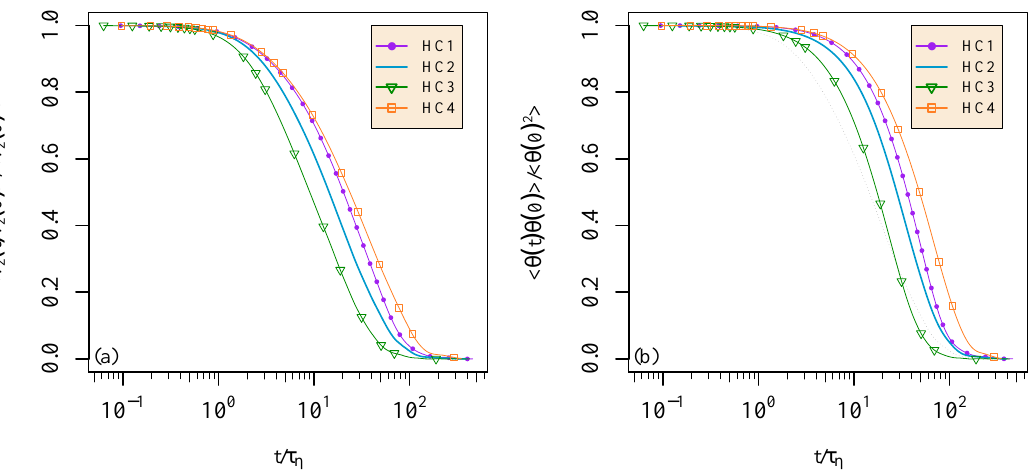
Figure 4. Lagrangian autocorrelation function of ( a ) the velocity aligned with gravity v z , and ( b ) the thermal fluctuations θ . In ( b ) a dotted grey line is provided in the background as a reference for the autocorrelation function of v z in the Pr = 1 simulation HC2. Time is given in units of the Kolmogorov time-scale τ η . Triangular brackets indicate an average over Lagrangian